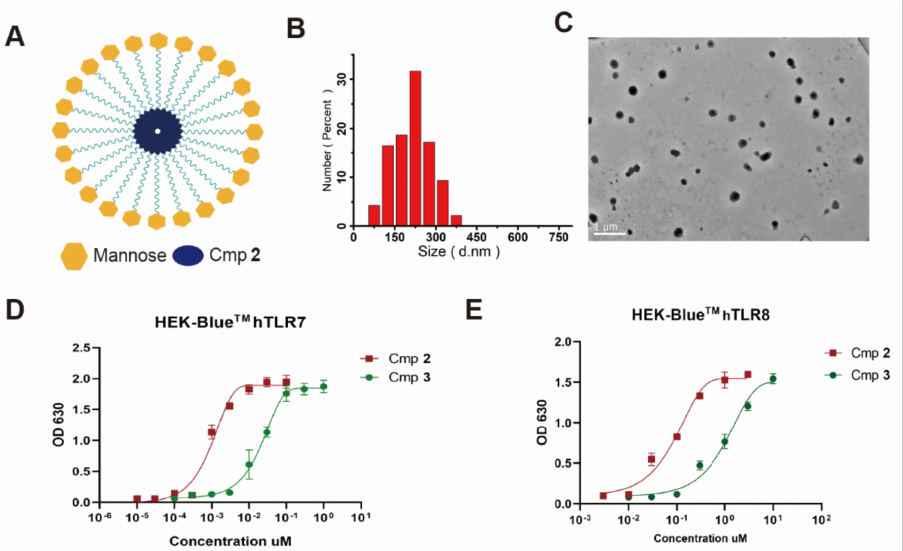
Figure 1. Self-assembled compound 3 (Cmp 3) stimulated TLR7 and TLR8 signaling. ( A ) Schematic diagram of self-assembled nanoparticles; ( B ) The nanoparticles diameter and size distribution were analyzed by Image J image software and origin 9 analysis software. ( C ) The TEM image (1.5 mg/mL) in PBS, 1% uranyl acetate solution was used to stain the sample, scale bar shows 1 µ m, ( D , E ) HEK-Blue TM hTLR7 (EC50, compound 2 : ~0.001 µ M, compound 3 : 0.017 µ M) and hTLR8 (EC50, compound 2 : 0.045 µ M, compound 3 : 0.6 µ M) cells were treated with the compound 2 and 3 for 14 h at the indicated concentrations, and the final OD values were collected at 630 nm. The data are shown as the mean ± SD (n ≥